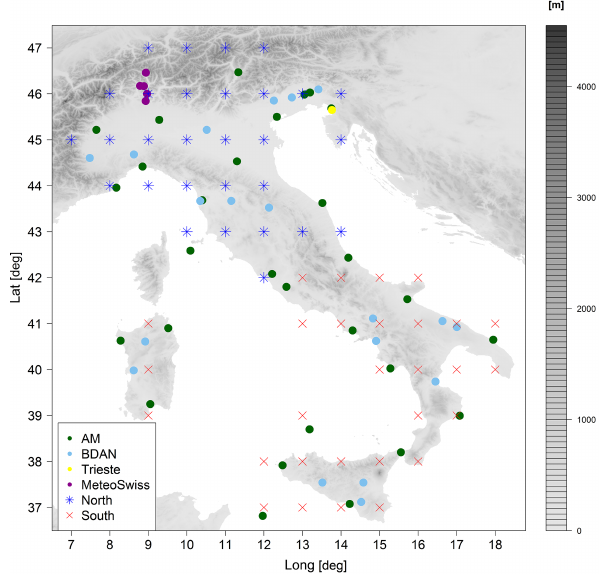
Figure 1. Spatial distribution of the stations and of the grid-mode version of the dataset (see Sect. 2.3): stars and crosses represent, re- spectively, northern (29 points) and southern (29 points) Italian grid points as clustered by a principal component analysis. The figure also shows the orography of the region and gives evidence of the sources of the station records, with green circles for AM series (29 series), blue circles for BDAN series (19 series), a yellow circle for the Trieste observatory and violet circles for MeteoSwiss series (5